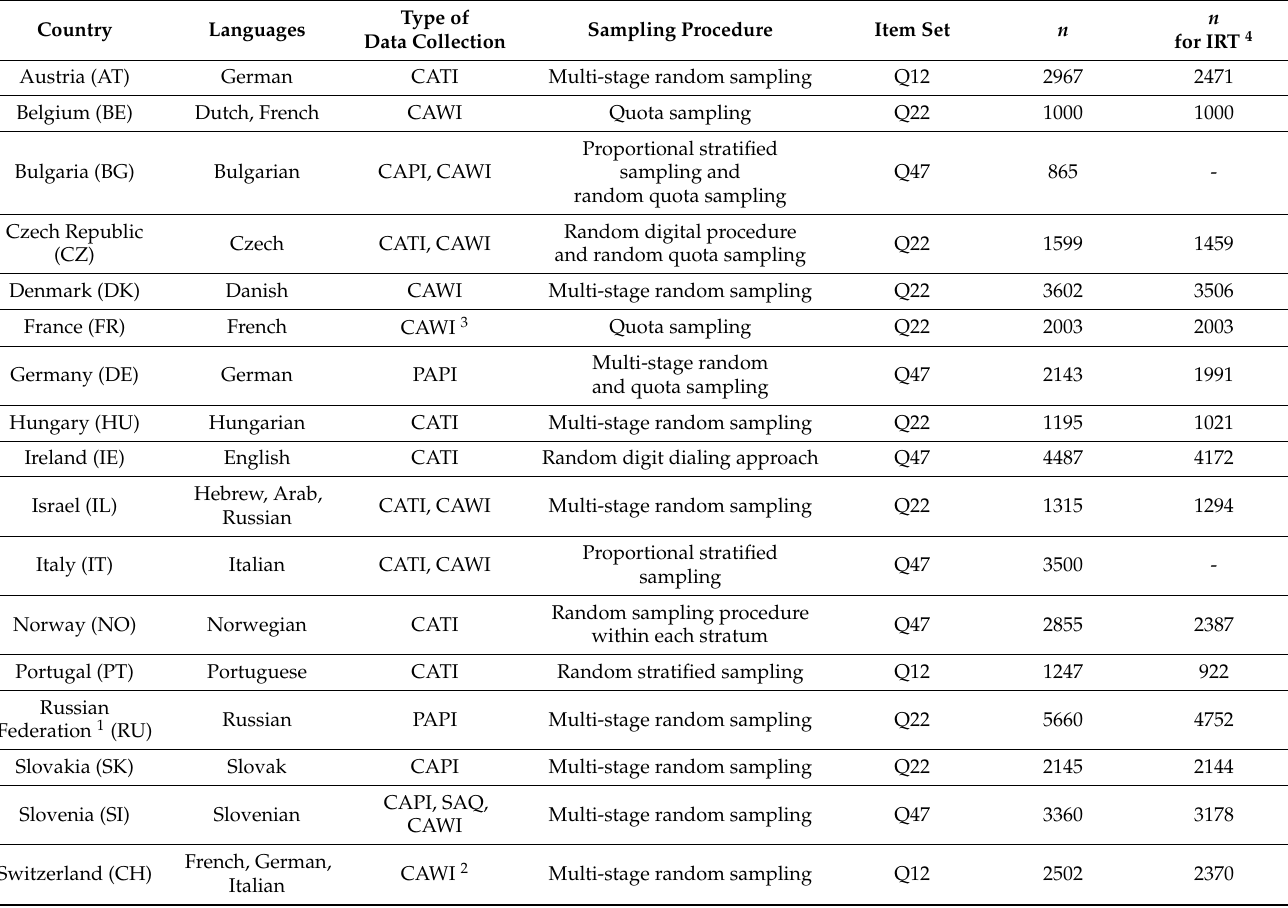
Table 2. Main characteristics of the national HLS 19